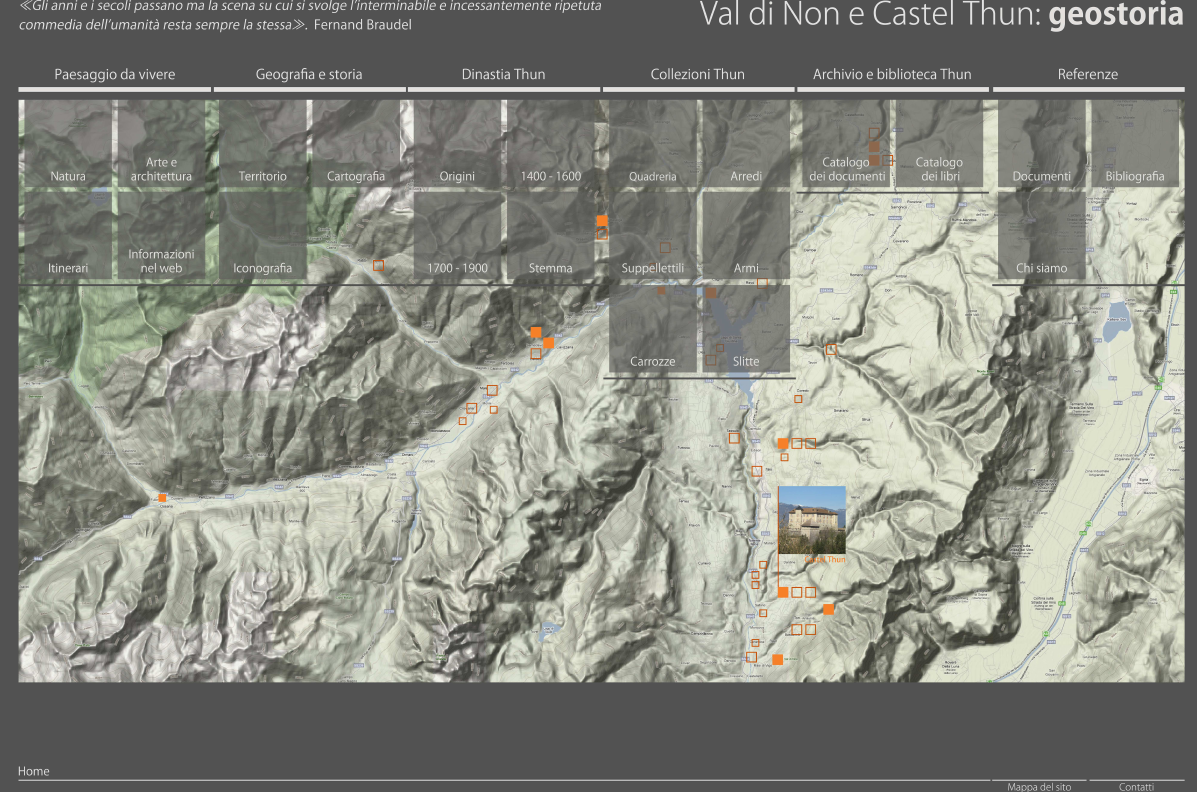
Figure 6. Website homepage: “Val di Non e Castel Thun: geostoria”